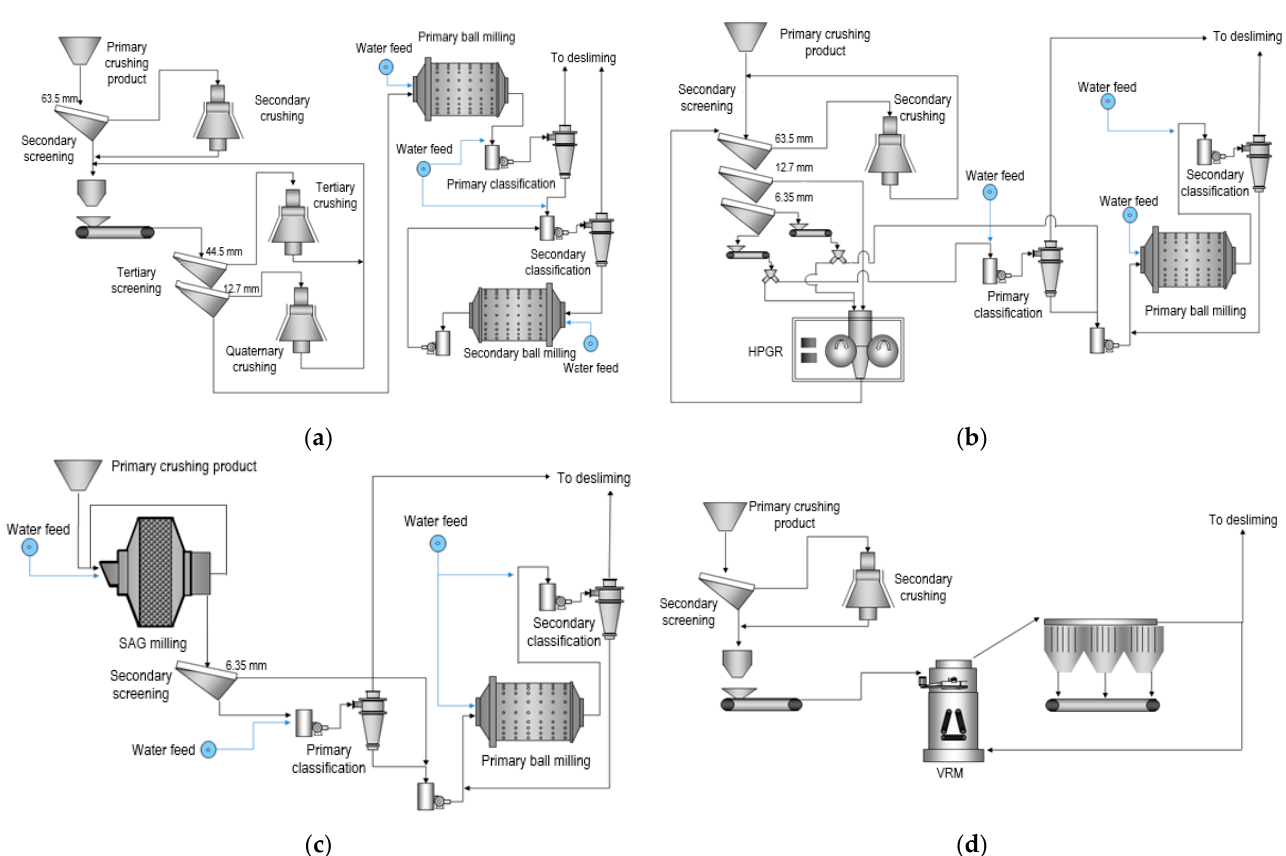
Figure 2. Comminution routes for the low-grade iron ore used as basis for comparison. Adapted from [11,16]. ( a ) Route #1; ( b ) Route #2; ( c ) Route #3; ( d ) Route #4.